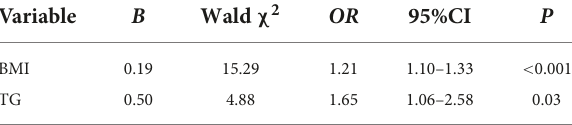
TABLE 5 Analysis of factors related to HUA in BPD